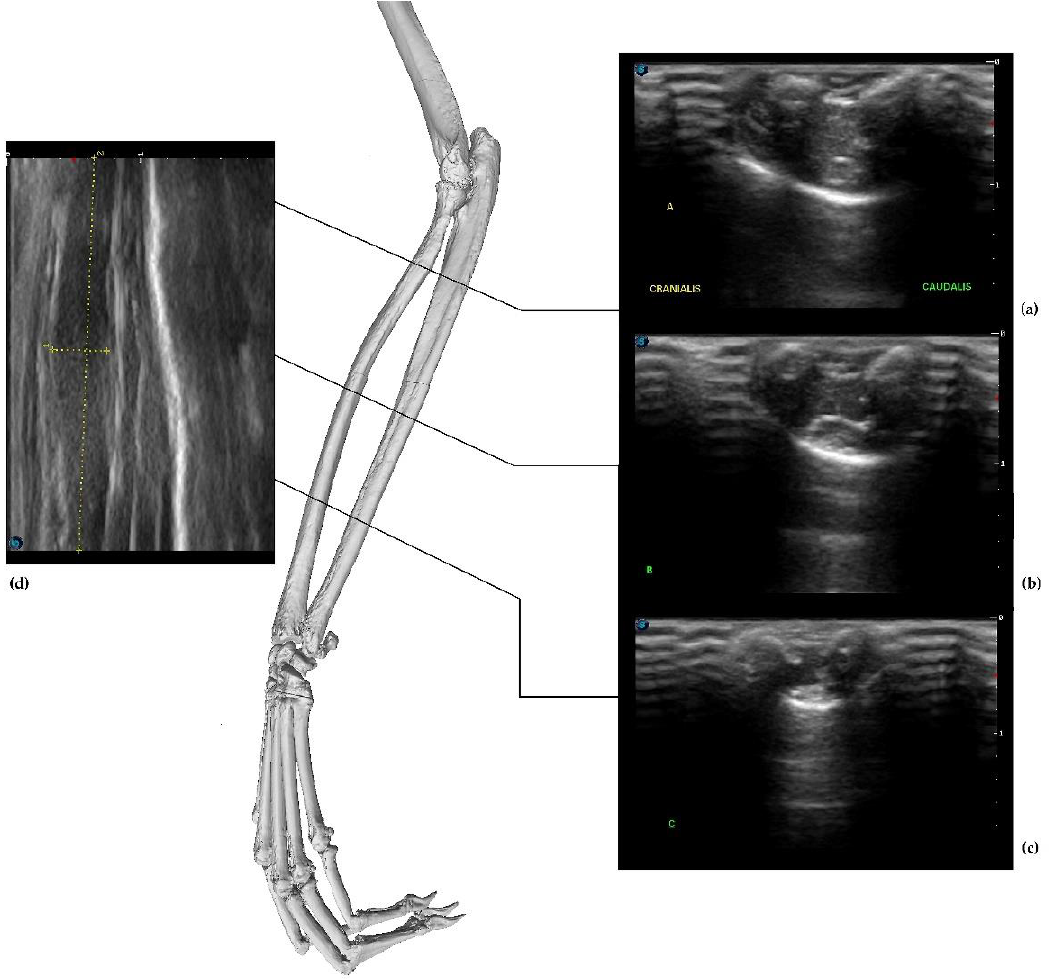
Figure 1. The transverse and longitudinal planes of the L. chrysomelas forearm. The ultrasound transducer was positioned on the lateral (in the transverse scan: ( a ) at the level of the proximal third of the forearm; ( b ) at half the length of the forearm; ( c ) at the level of the distal third of the forearm) and medial portion; ( d ) in the sagittal scan). The cross-section lines show transverse scans on the 3D bone reconstruction model (radius–cranial), (ulna–caudal).